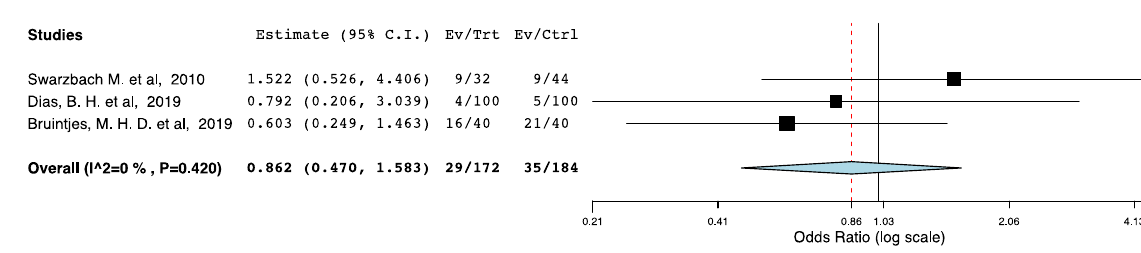
Figure 2. Forest plot: overall complications (ERAS vs. traditional perioperative care).